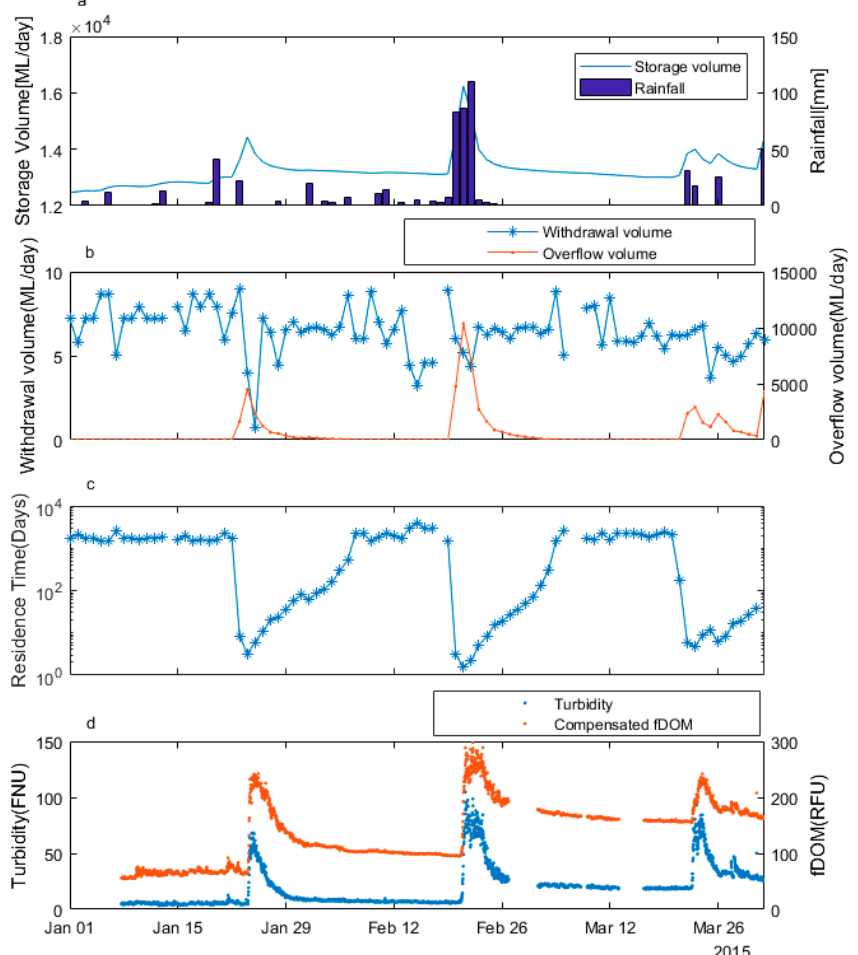
Figure 6. ( a ) Daily rainfall (mm d − 1 ) and daily storage volume (ML), ( b ) outflow (withdrawal and overflow via spillway) (ML d − 1 ), ( c ) residence time (Days), ( d ) hourly turbidity (FNU) and compensated fDOM (RFU) at the depth of 10 m for the period 1 January 2015 to 1 April 2015 for Tingalpa Reservoir.